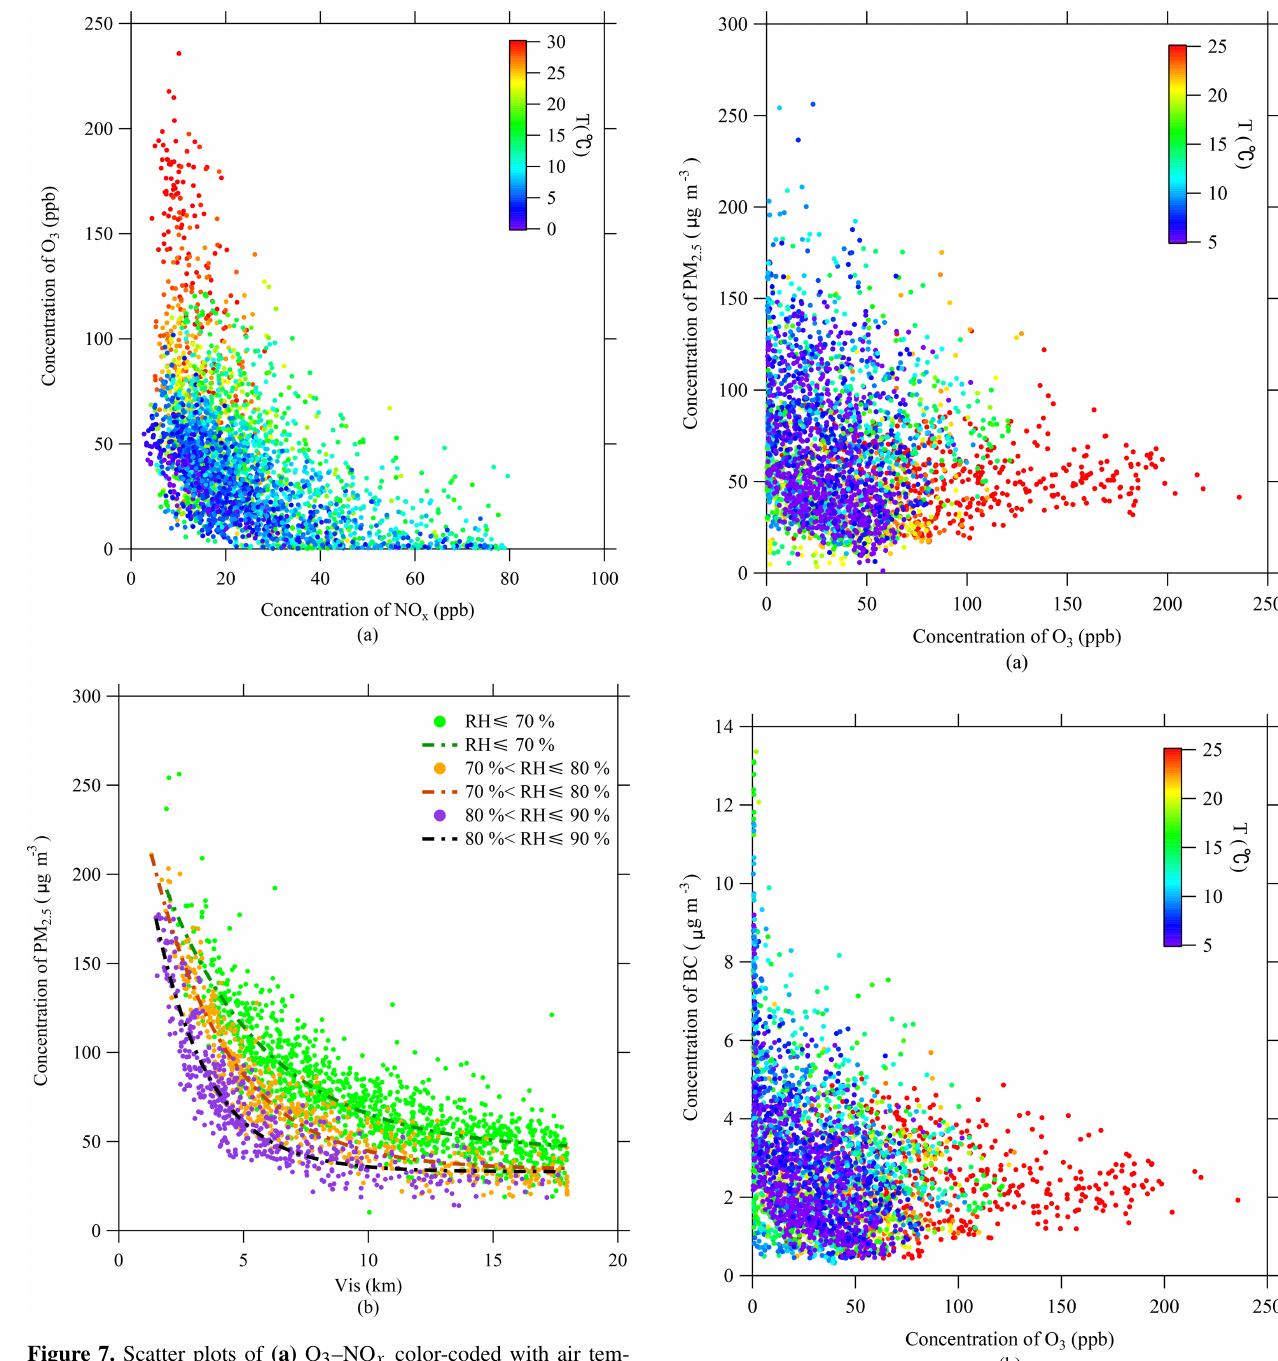
Figure 7. Scatter plots of (a) O 3 –NO x color-coded with air tem- perature ( T ) and (b) PM 2 . 5 –Vis color-coded with relative humidity (RH).